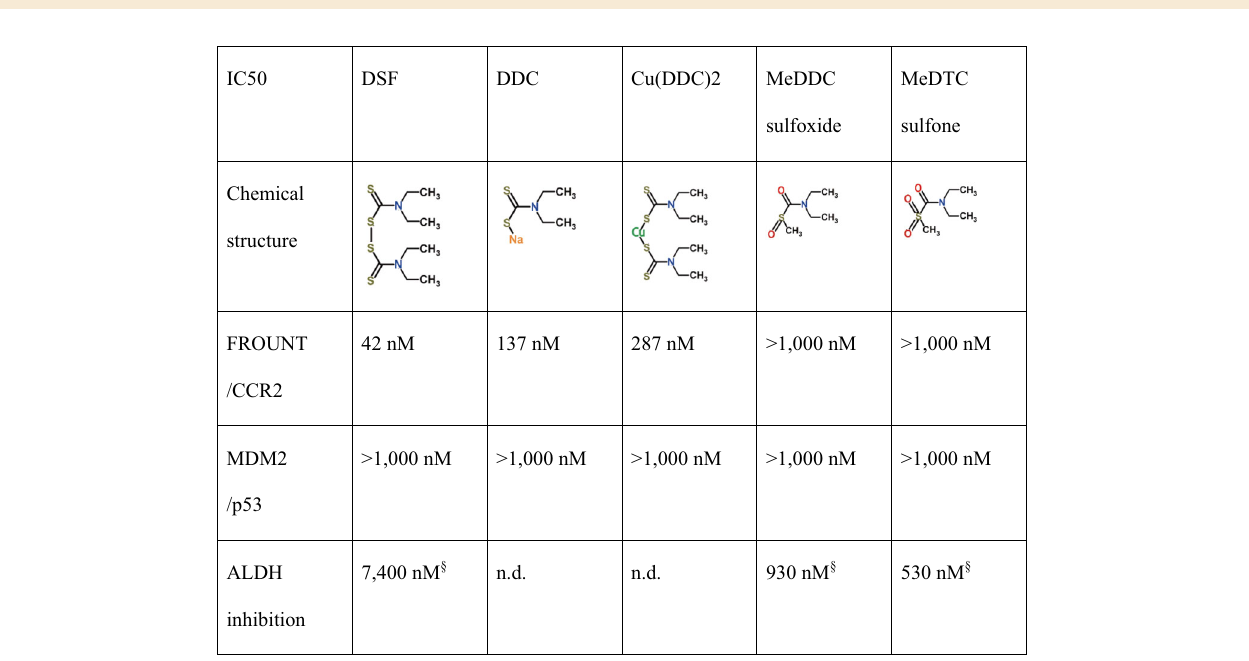
Table 1 Inhibition properties of DSF and its